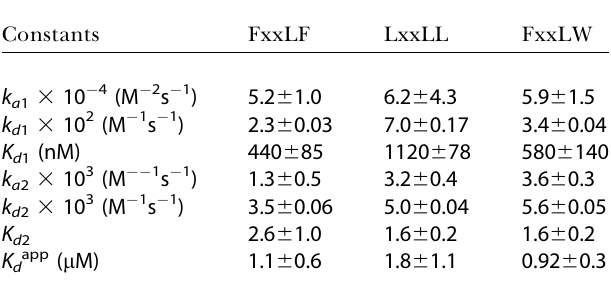
as well as buried surface areas for each complex, are listed in Table 2. The structures confirm previous suggestions that AR utilizes a single binding interface for LxxLL and non- canonical aromatic-rich motifs (He et al. 2000, 2002a). Only